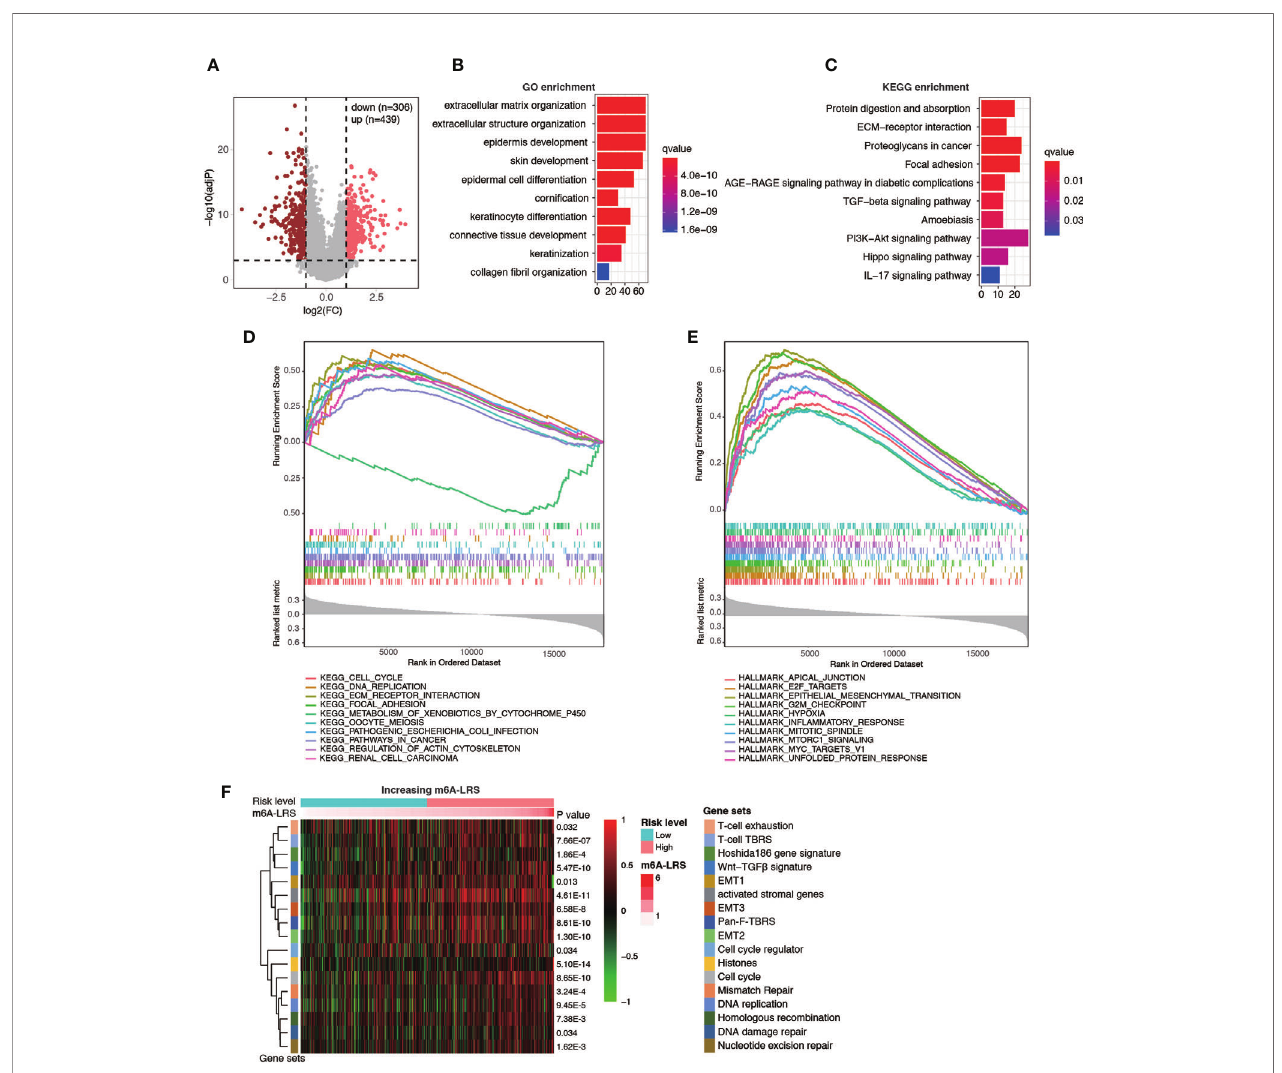
FIGURE 5 | Functional analysis of genes associated with the m6A-related lncRNA risk score. (A) Volcano plot showing the distribution of differentially-expressed genes (DEGs) between high- (top 25%) and low-risk (bottom 25%) subgroups. (B, C) Top 10 enriched Gene Ontology (GO) and Kyoto Encyclopedia of Genes and Genomes (KEGG) pathways of DEGs. (D, E) Gene set enrichment analysis (GSEA) of KEGG pathways and tumor hallmarks associated with m6A-LRS. (F) Gene set variation analysis showing the activation states of biological and immune signatures in the high- and low-risk subgroups. A heatmap was used to visualize